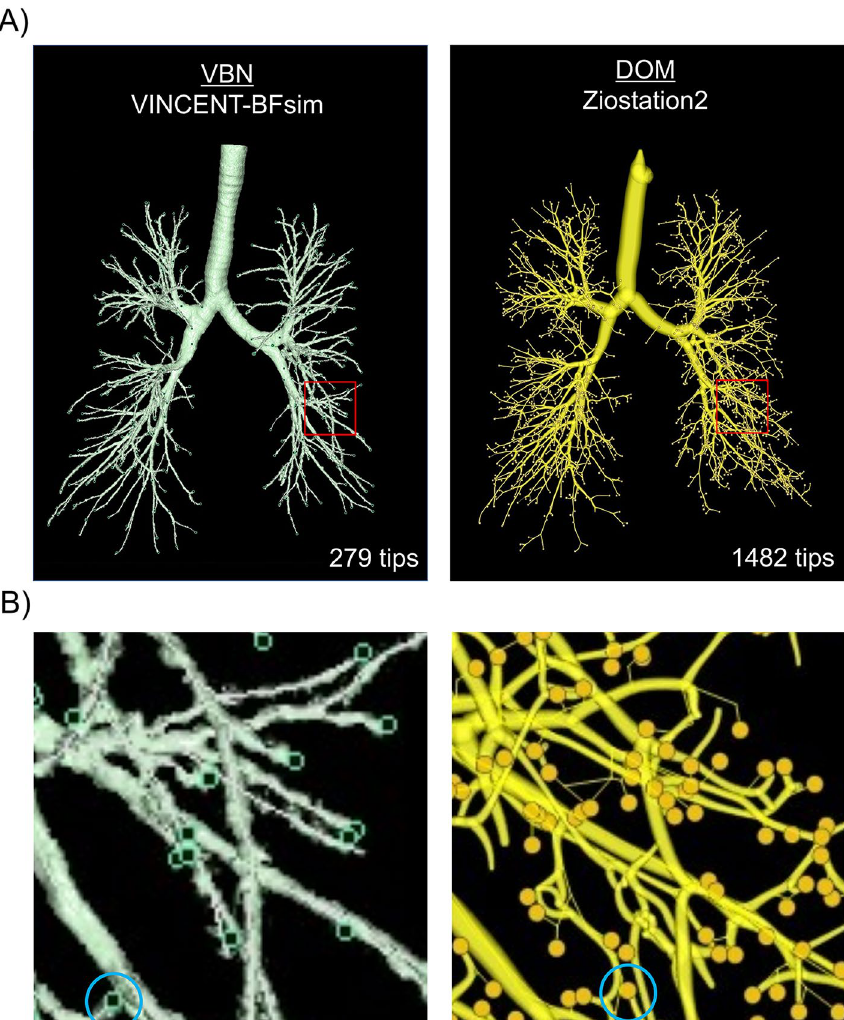
Figure 1. Bronchial trees were reconstructed by automatic CT analysis using virtual bronchoscopic navigation software and by manual CT analysis using the direct oblique method (DOM). ( A ) Images of the entire bronchial trees. The virtual bronchoscopic navigation software, VINCENT-BFsim, identified 279 bronchial tree tips in the whole lung, while the DOM on Ziosation2 identified 1482 tips. The areas indicated by red squares are magnified in ( B ). ( B ) Magnified images of the bronchial trees. The tips of the bronchial trees are shown as round dots. The blue circles indicate examples of